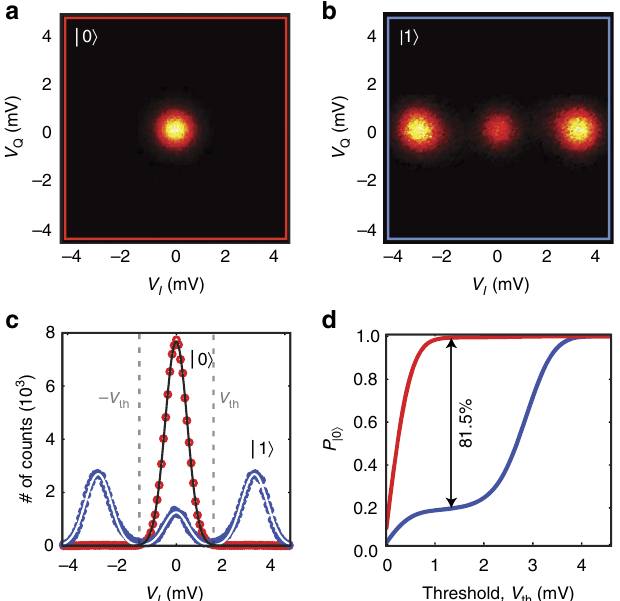
Figure 5 | Quadrature voltage histograms of the parametric oscillator output collected after digital sampling. The pump bias point was d |0 i / G ¼ (cid:2) 5.34, E = G ¼ 3 : 56. In ( a ), the qubit was in its ground state; in ( b ), a p -pulse was applied before the read-out pulse. ( c ) 1D histograms of the in-phase voltage component, V I , from the quadrature histograms in a and b . The black and white solid lines are Gaussian fits, from which we extracted a signal-to-noise ratio of 3.39. ( d ) Cumulative distribution functions, corresponding to the |0 i and |1 i states, obtained by sweeping a threshold voltage, V th , from the centre of the two histograms ( V I ¼ 0). The maximum separation between the two S-curves yields a state discrimination of